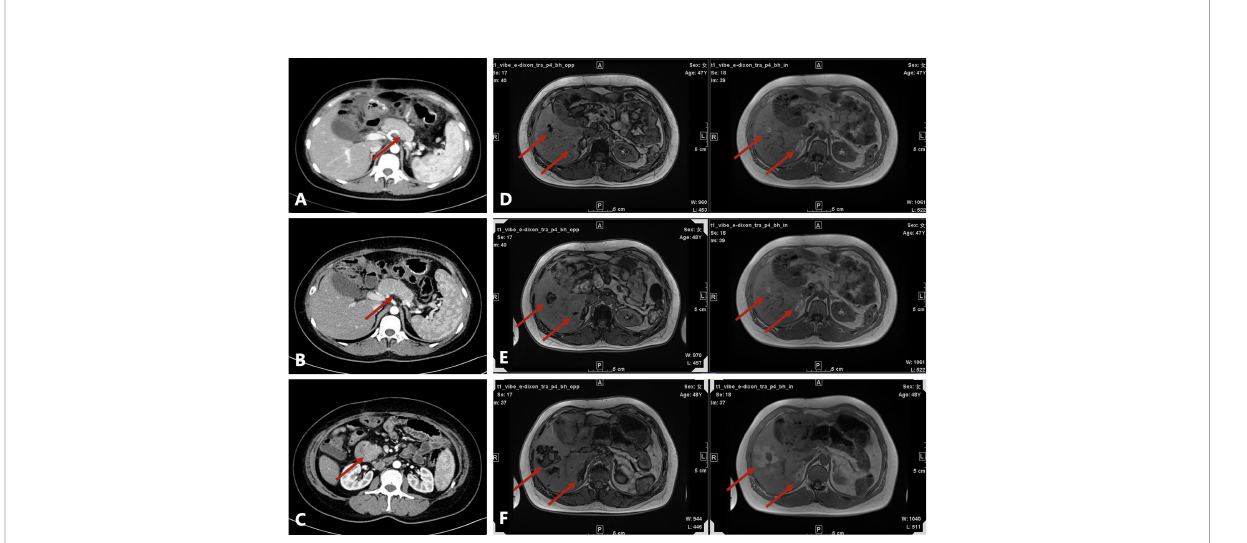
FIGURE 1 Radiological evaluation before and after surgery. (A) Irregularly shaped pancreas seen on contrast-enhanced computed tomography (CT) at the fi rst admission. (B) Enlarged pancreas on contrast-enhanced CT before surgery. (C) Head of the pancreas protruding into the duodenum on contrast-enhanced CT before surgery. (D – F) Axial T1-weighted in-phase and out-of-phase images obtained during follow-up (D, 1.5 years after surgery; E, 2 years after surgery; F, 2.5 years after surgery). There were several patchy and nodular high-signal lesions in the right lobe of the liver on the in-phase image. Note a signi fi cant signal drop in these lesions on the opposed-phase image. The lesions gradually enlarged during follow-up. A nodule inside the largest lesion was detected in the last follow-up